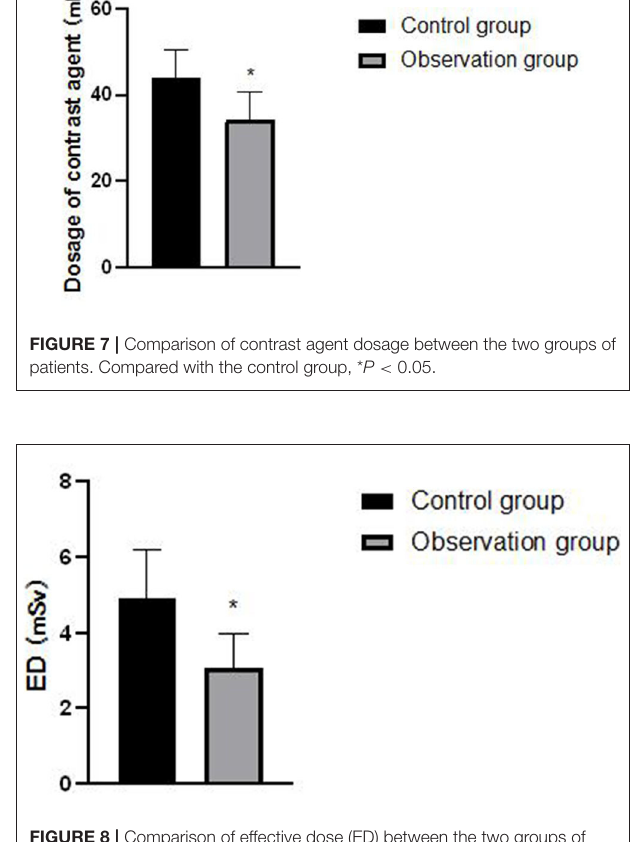
FIGURE 8 | Comparison of effective dose (ED) between the two groups of patients. Compared with the control group, * P <